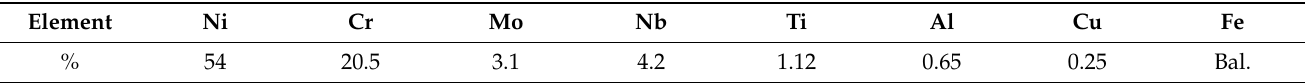
Table 1. Elemental chemical composition of Inconel 718